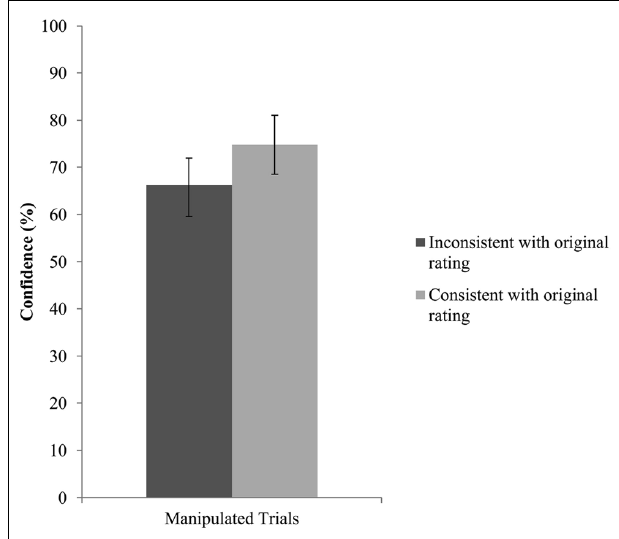
FIGURE 4 | Confidence as a function of consistency with the original sympathy rating for all manipulated trials. Error bars represent 95% confidence intervals.